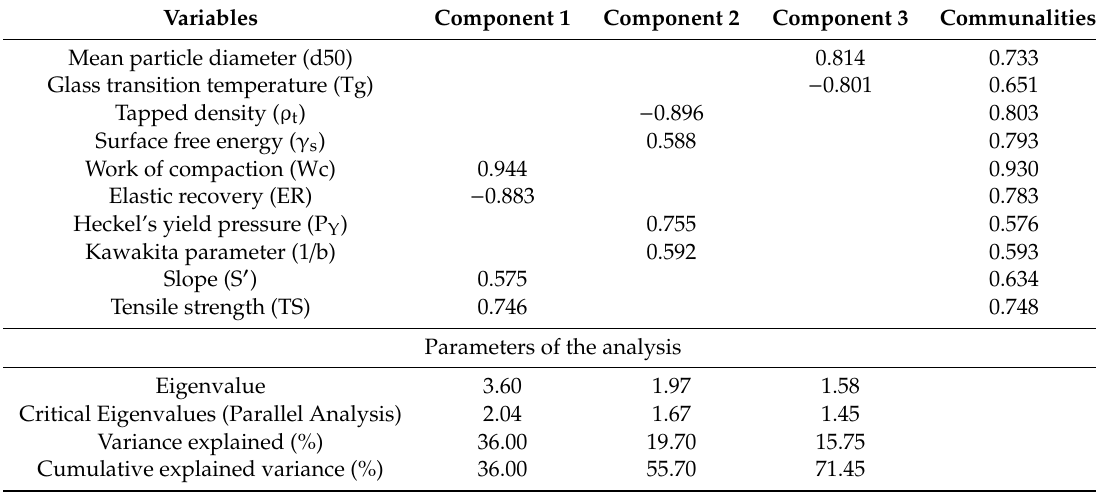
Table 7. Components obtained from the Principal Component Analysis (varimax rotation) with loadings greater than